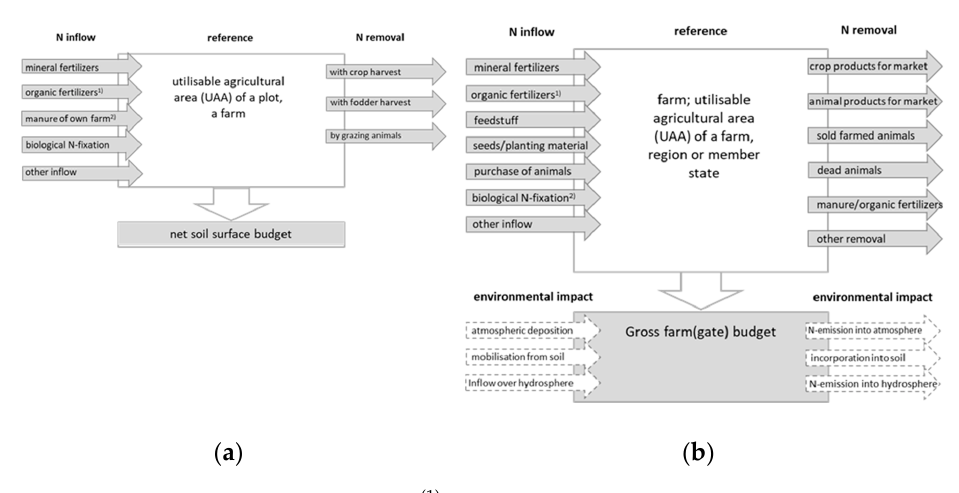
Figure 1. ( a ) Net (soil) surface budget [3; 27]: (1) manure from other farms, organic and organic ‐ mineral